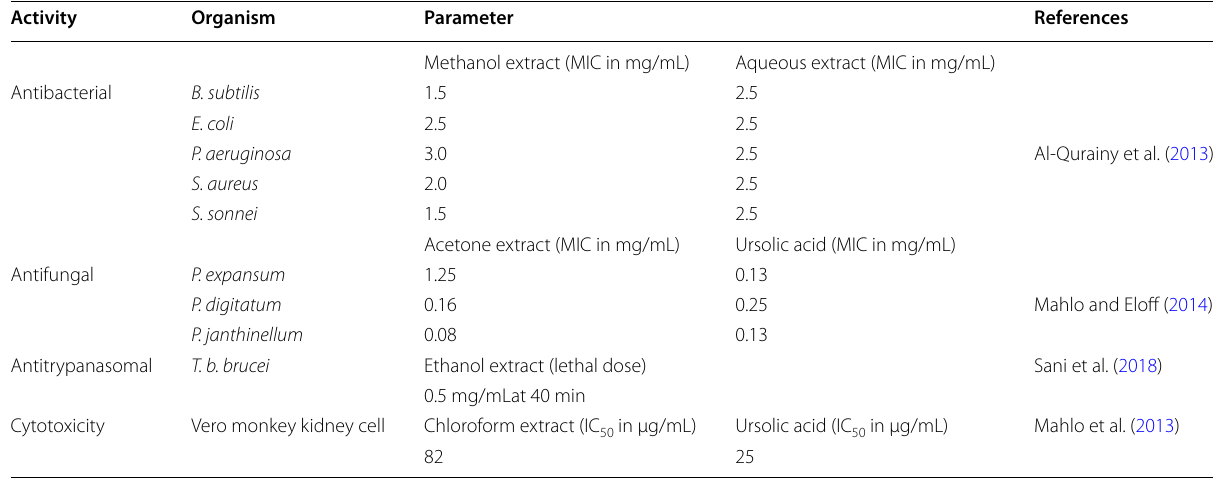
MIC: minimum inhibitory concentration; IC 50 : median inhibitory concentration